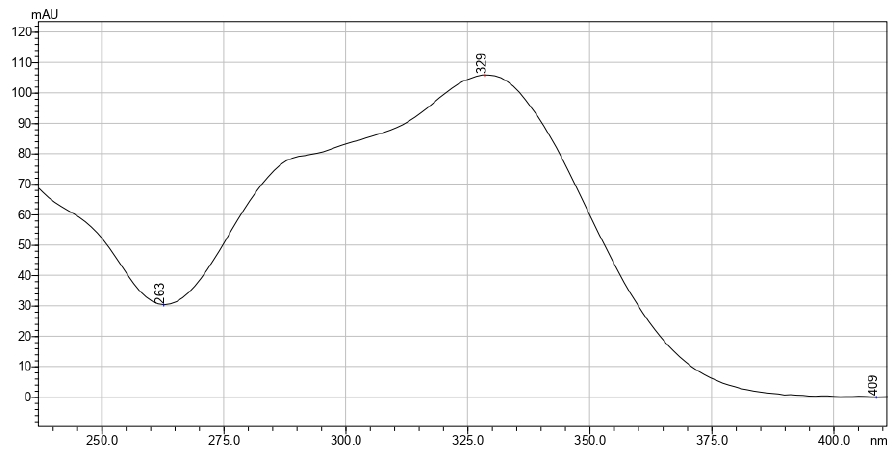
Figure 3. Absorption spectrum of chlorogenic acid isolated from T. vulgare extracts.